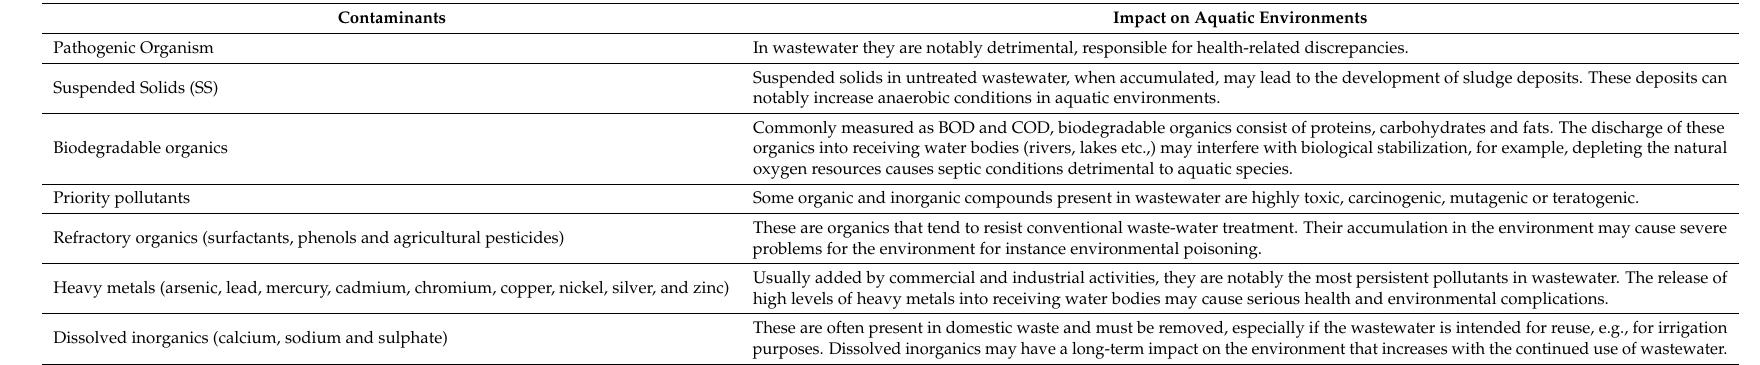
Table 1. Wastewater-related